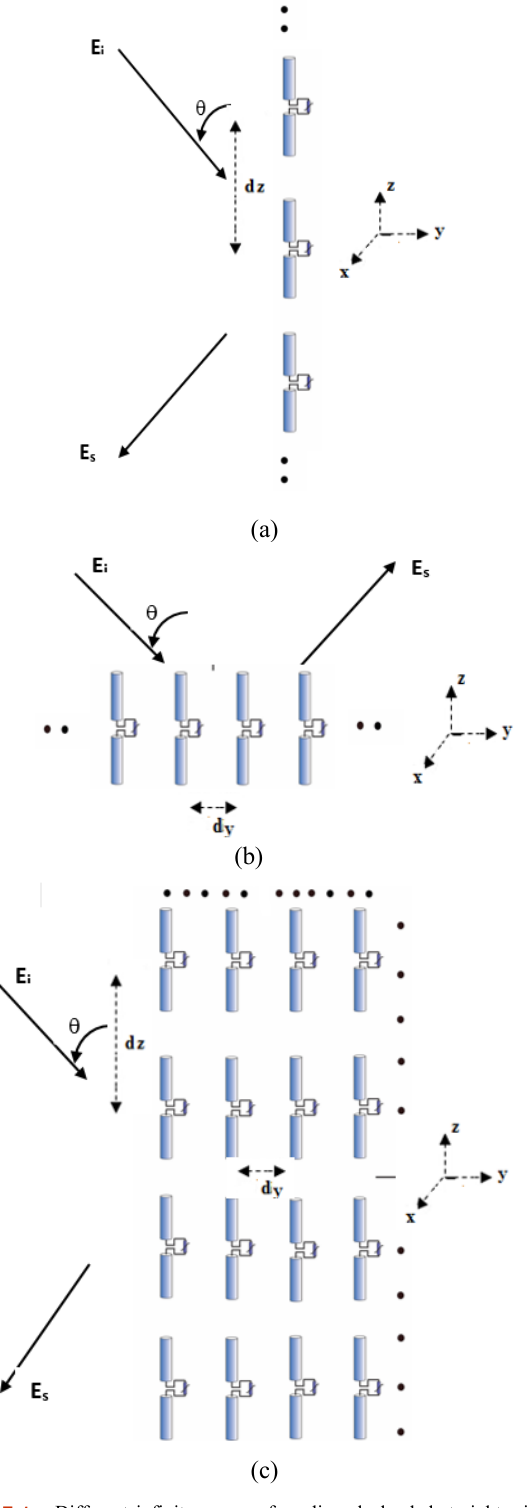
FIGURE 1. Different infinite arrays of nonlinearly loaded straight wire antennas arranged in (a): collinear, (b): parallel, and (c): planar structures .